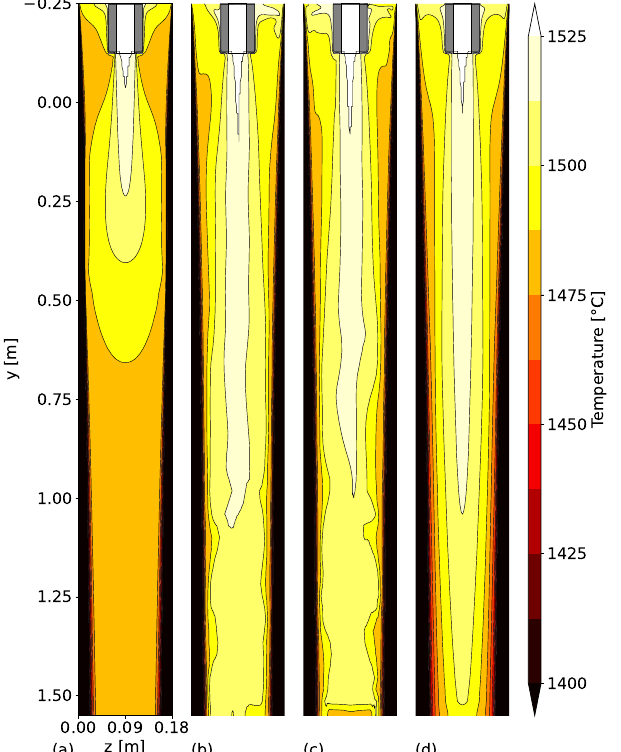
Figure 7. Temperature field at VA2. ( a ) k − ε model; steady-state; ( b ) LES model at t 1 = 205 s; ( c ) LES model at t 2 = 1096 s; ( d ) LES model; time-average.